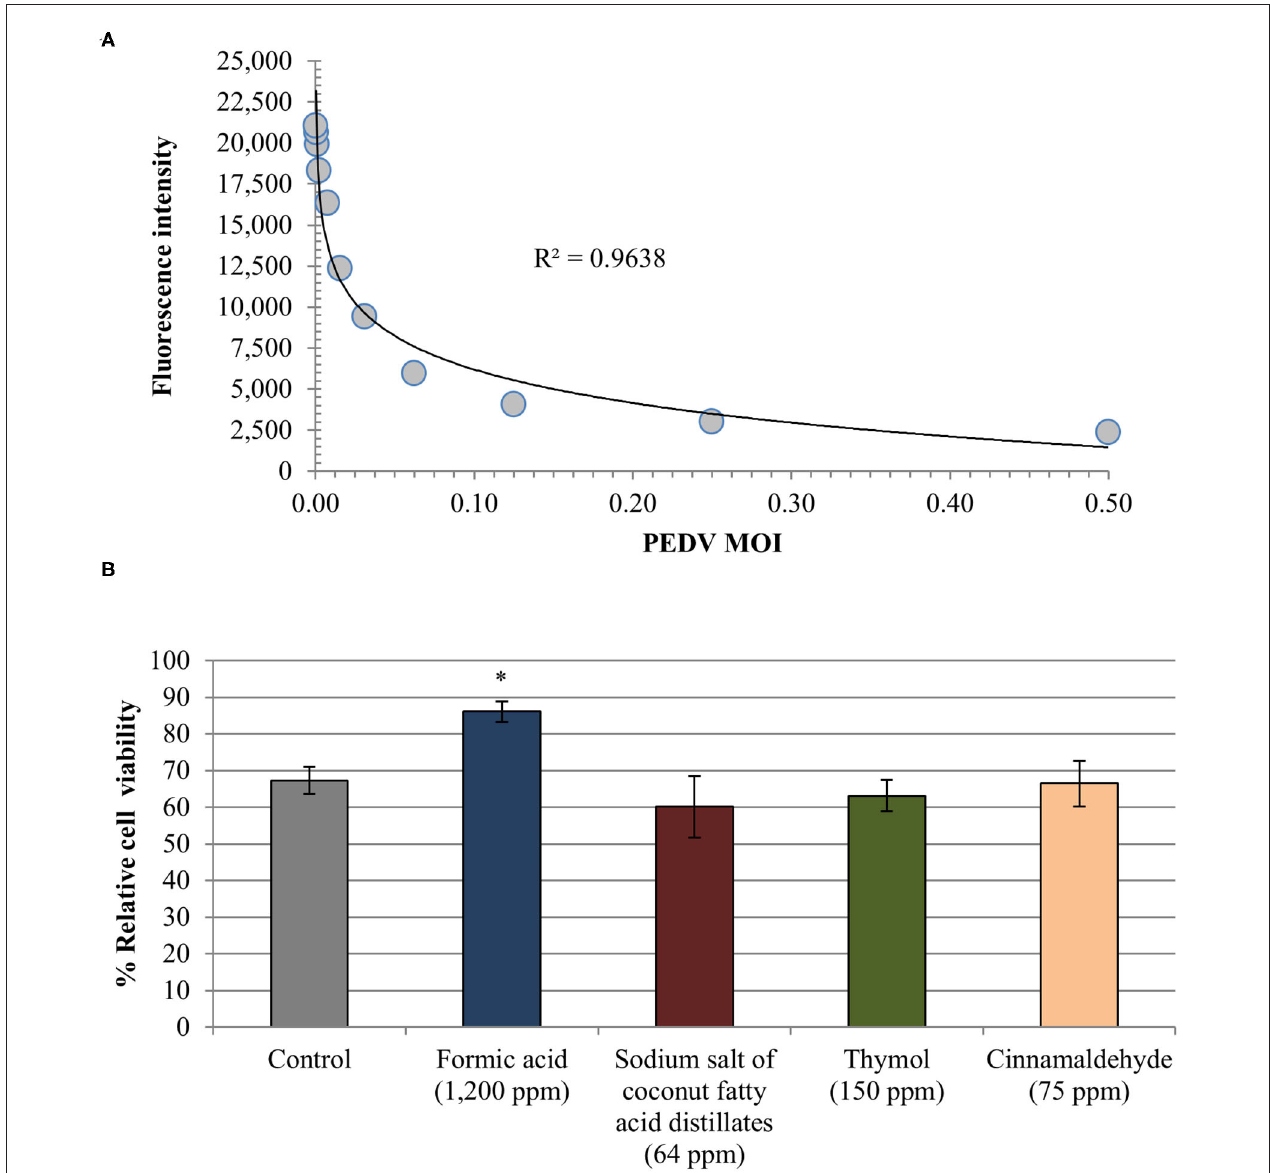
FIGURE 3 | Anti-PEDV activity of two organic acids, formic acid and sodium salt of coconut fatty acid distillates, and two single EO compounds, thymol and cinnamaldehyde, determined in Vero cells by means of an alamarBlue assay for estimating cell viability. (A) Standard curve generated from fluorescence intensity associated with exposition to serial dilutions of PEDV (TCID 50 /cell). Linear trend line and R 2 value obtained are shown. (B) Relative cell viability rate [(mean fluorescence of treated-PEDV infected wells/mean fluorescence of treated non-infected wells) × 100]. Data are expressed as mean of the independent replicates ± standard deviations. *Statistically significant differences with regard to controls ( p <